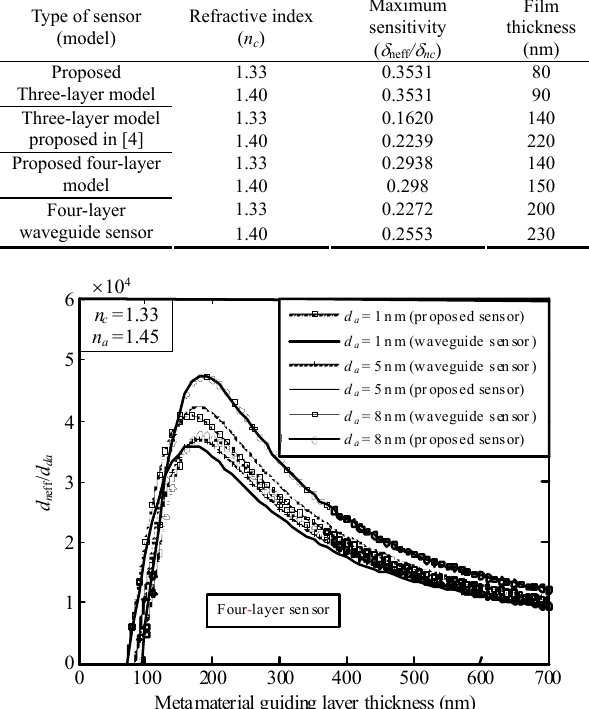
Fig. 5 Plot of adlayer sensitivity variation against film thickness of proposed and conventional four-layer sensors for adlayer refractive index n a = 1.45, in which the refractive indices used are: n s = 1.471 and n c = 1.33.